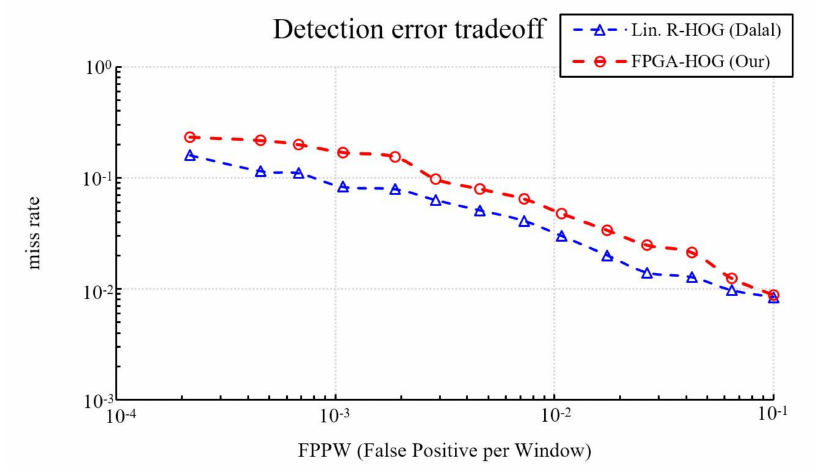
Figure 10. Comparing our fixed-point implementation with Dalal’s on the INRIA person